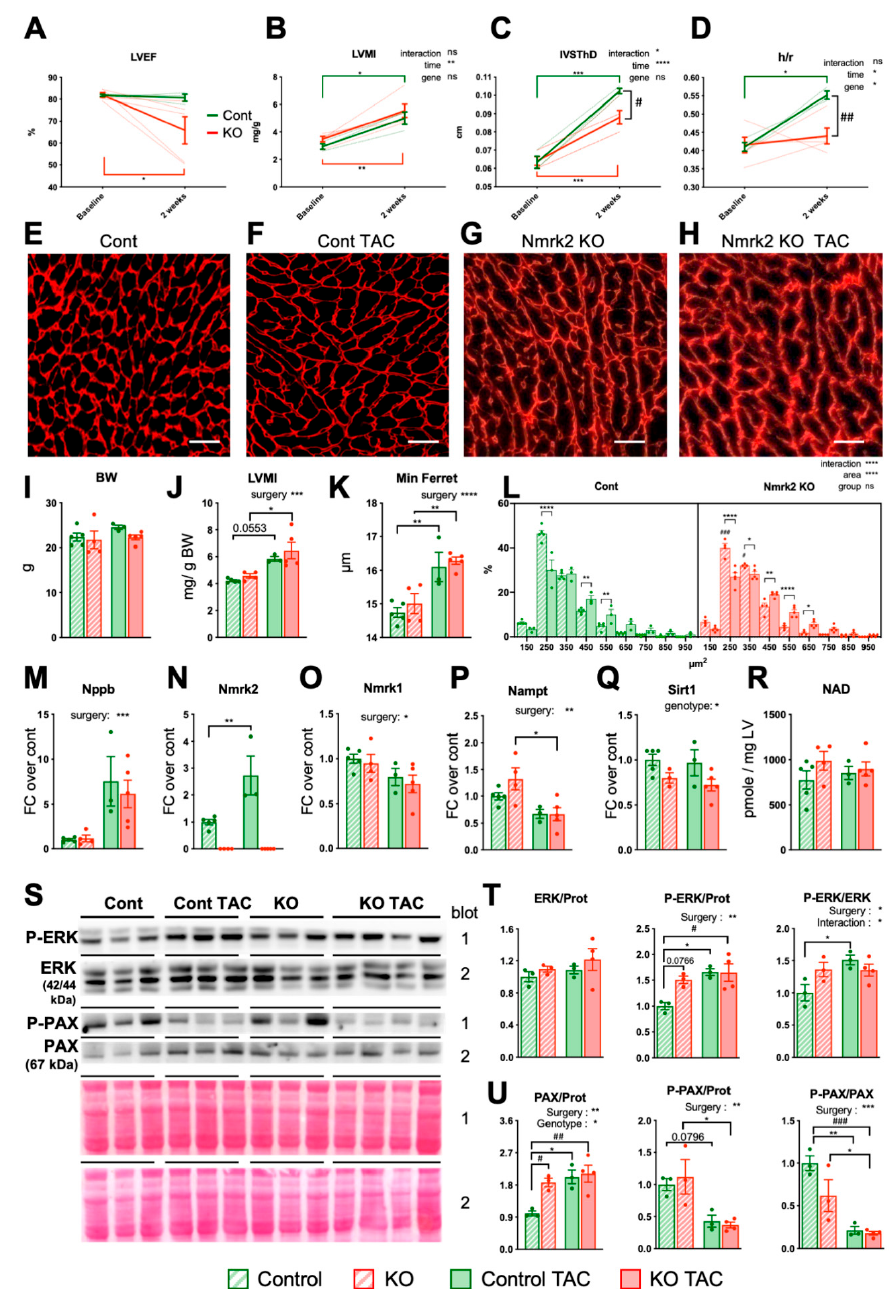
Figure 3. Nmrk2-KO mice develop cardiac hypertrophy in response to transverse aortic constriction. Control mice ( n = 3) and Nmrk2-KO mice ( n = 5) were subjected to transverse aortic constriction (TAC) and sacrificed 15 days later for histological and molecular analyses. ( A–D ) Echocardiography before surgery (baseline) and after TAC (see accompanying Table 1). ( A )Left ventricular (LV) ejection fraction. ( B ) LV mass index. (C) End-diastolic interventricular septum thickness. ( D ) LV wall thickness to radius ratio (end diastole). Data are shown a mean (full line) +/ SEM. Individual data are shown as dotted lines. ( E – H ) Cardiac sections stained with anti-laminin α 2 antibody to demarcate cell boundaries, scale bars = 20 µ M. (representative picture of n = 3 mice per group) ( I – R ) Post-sacrifice analyses of controls TAC ( n = 3) and Nmrk2-KO TAC mice ( n = 5) and age-matched 6 week-old controls ( n = 4–5) and KO ( n = 4–3) Body weight. ( J ) Left ventricular mass index at sacrifice. ( K ) Cardiomyocytes diameter (minimum Feret). ( L ) Cardiomyocytes area frequency plot. ( M – Q ) Relative expression by RT qPCR of indicated genes. Data normalized on Gapdh reference mRNA level. ( R ) Myocardial NAD levels. ( S ) Western blot analysis of ERK and Paxillin (PAX) total and phosphorylated form (P). ( T,U ) Quantification of western blots in panel S using Ponceau staining in the same region of the blot for normalization of loading. Throughout the